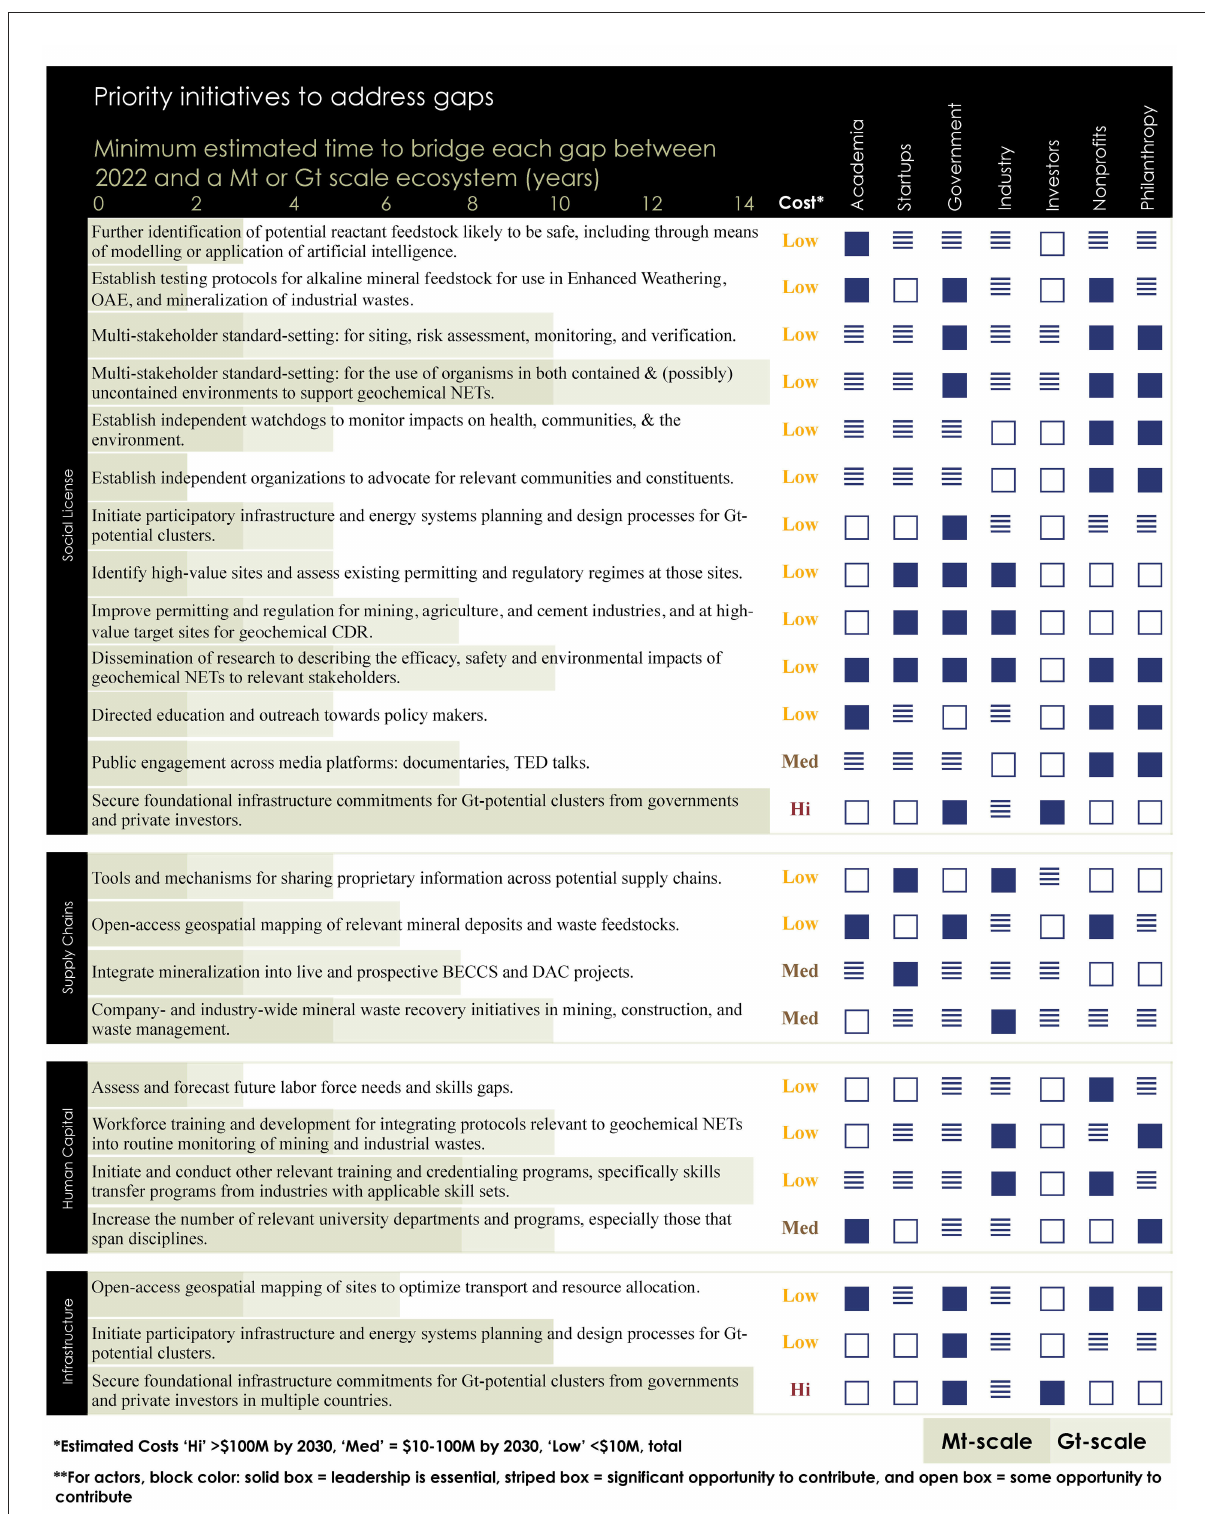
FIGURE2 Proposed priority initiatives and relevant actors, based on assessment of our work presented in Campbell et al. (2022), along with previous reports and roadmapping efforts (National Academies of Sciences, Engineering, and Medicine, 2019; Sandalow et al., 2021; Ocean Visions, 2021). Solid blue squares indicate a role in which leadership is essential, striped squares indicate a role in which there is significant opportunity to contribute, and open squares indicate a role in which there is some opportunity to contribute. The provided cost estimates represent